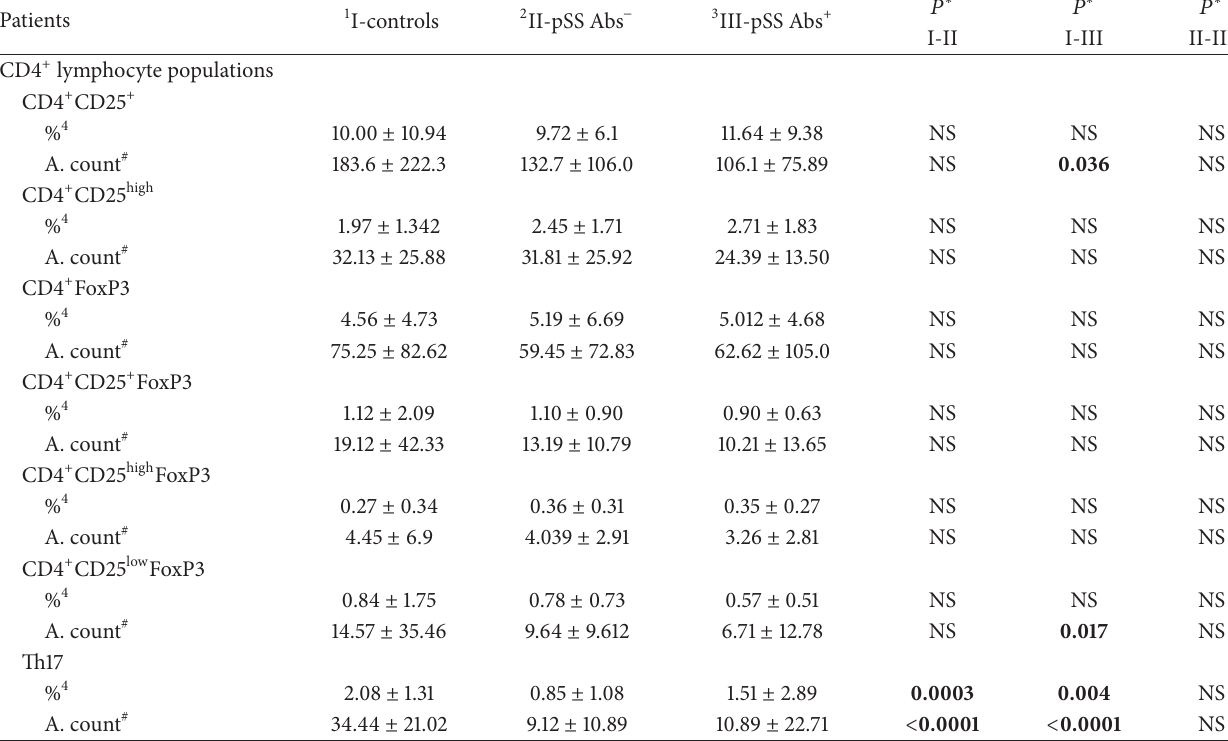
Table 3: Distribution of CD4 + lymphocyte subpopulations in peripheral blood of pSS patients and controls.